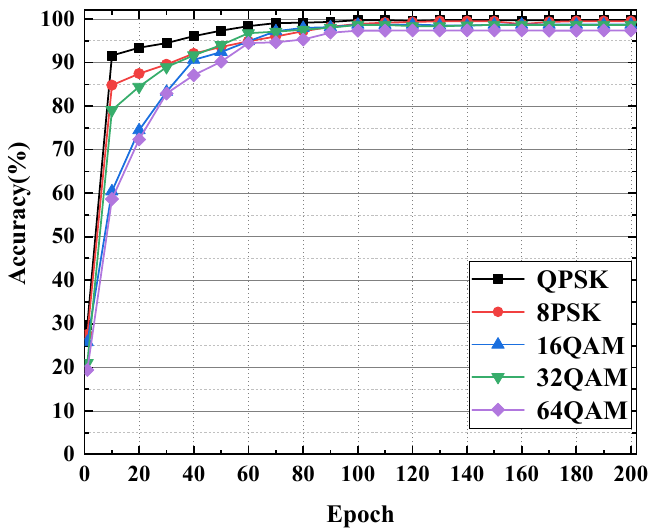
Figure 7. OSNR monitoring accuracy at di ff erent epochs.